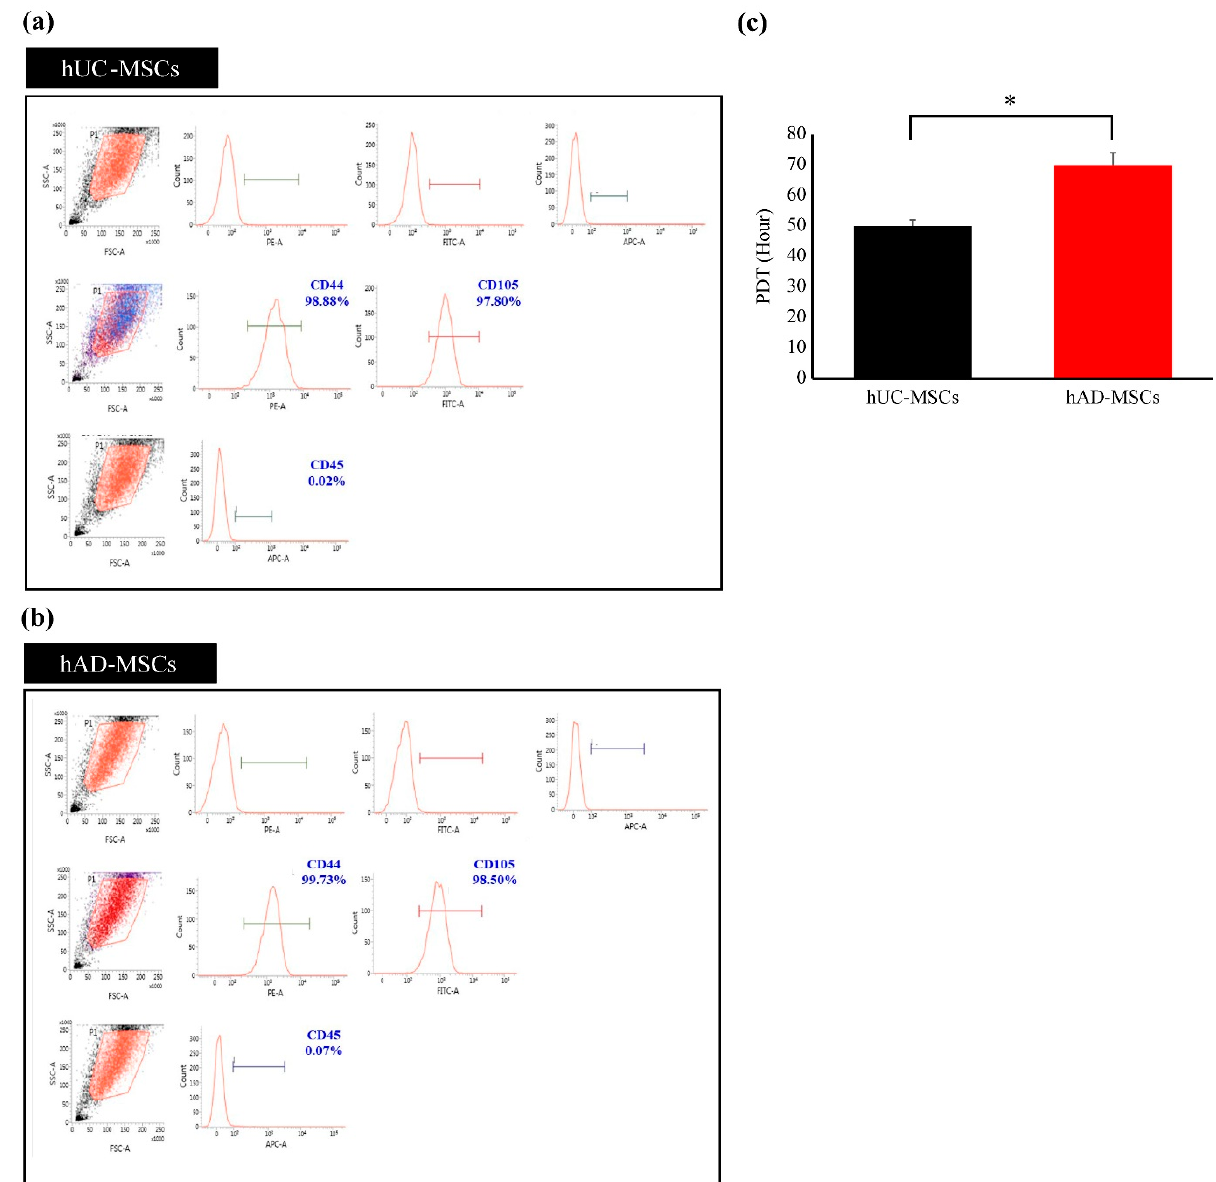
Figure 1. Analysis of mesenchymal stem cell markers using flow cytometry. In a sample of MSCs, ≥ 97% of MSCs must express CD44 as well as CD105 but not (<1%) CD45. ( a ) Marker expression in hUC-MSCs. ( b ) Marker expression in hAD-MSCs. ( c ) Population doubling time for passages 1–3. The doubling times of the hUC-MSCs and hAD-MSCs were calculated as per the Patterson formula. Data are presented as the mean ± standard error of the mean ( n = 5; hUC-MSCs vs. hAD-MSCs, * p < 0.05). Abbreviations: hUC-MSCs, mesenchymal stem cells derived from human umbilical cord tissue; hAD-MSCs, mesenchymal stem cells derived from human adipose tissue.